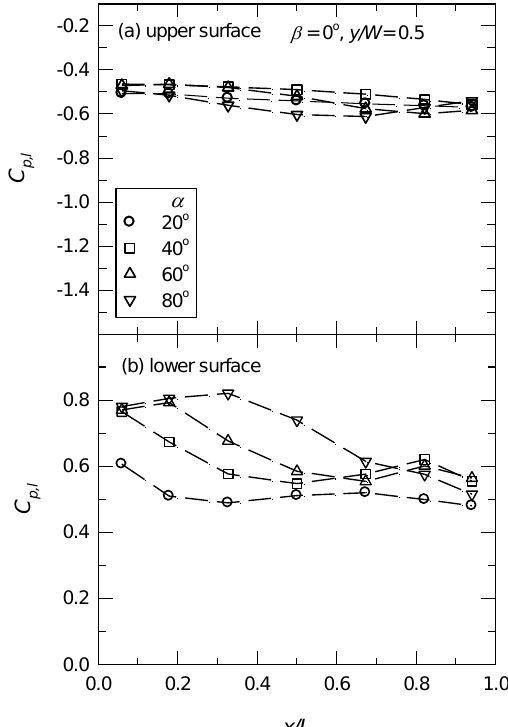
Figure 2. Mean longitudinal pressure distributions for y/W = 0.5 and β = 0°.